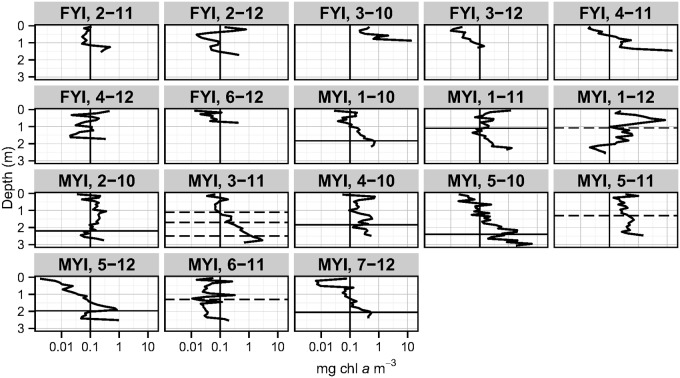
Vertical profiles of chl a concentrations for all cores.Solid horizontal lines represent identified annual layers used in the analyses and dashed horizontal lines represent potential annual layers not used in the analyses (x-axis is log scale).